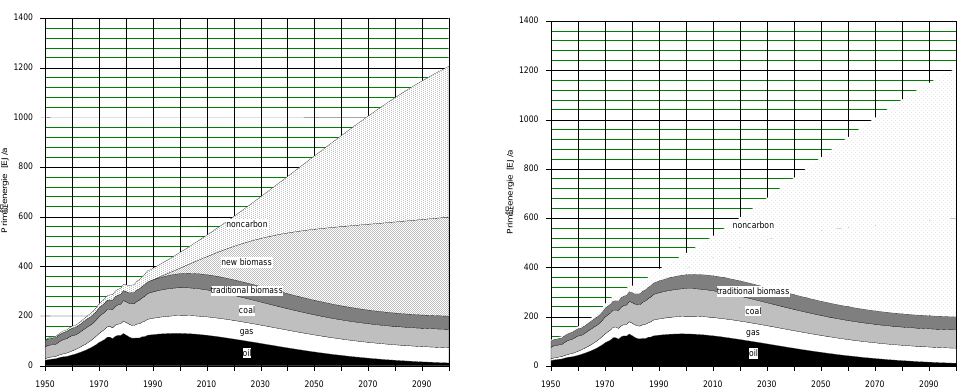
Figure 10. How the assumed (moderate) energy demand until 2100 is covered by single energy carriers. While overall energy supply is identical in both cases, the energy demand covered by biomass at left is covered by non-carbon sources at right—thus allowing C-neutrality to be assessed.